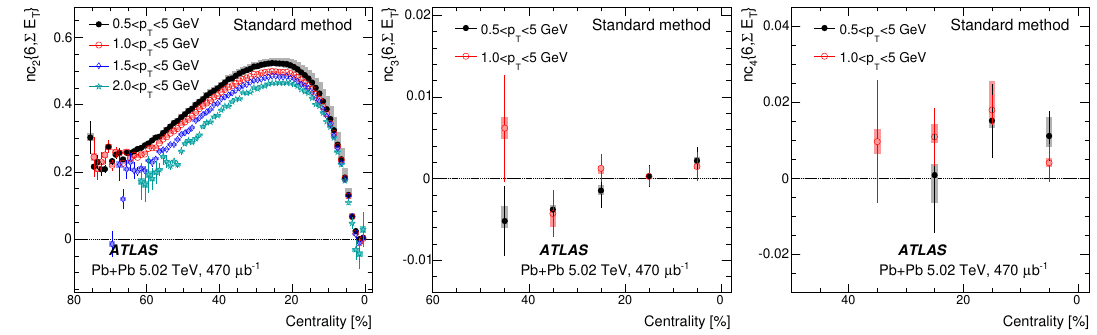
Figure 6 . The centrality dependence of normalized six-particle cumulants nc 2 f 6 ; (cid:6) E T g (left panel), nc 3 f 6 ; (cid:6) E T g (middle panel), and nc 4 f 6 ; (cid:6) E T g (right panel) obtained with the standard method for several p T ranges. The error bars and shaded boxes represent the statistical and systematic uncertainties, respectively. Zero is indicated by a dotted